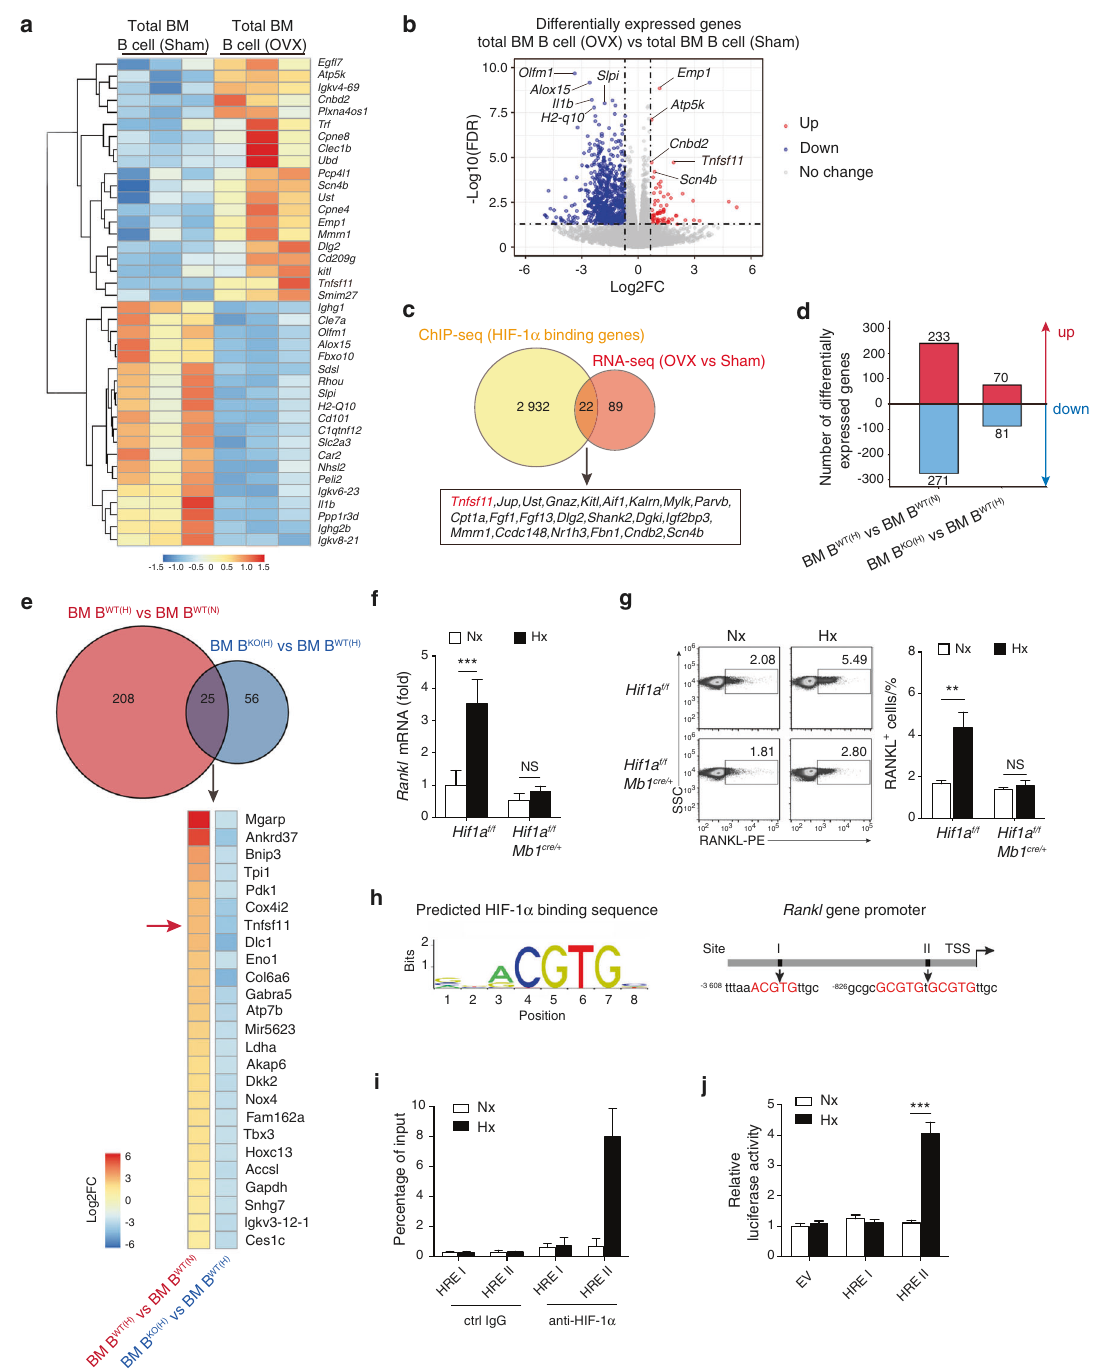
Fig. 2 HIF-1 α signaling activation in B cells enhances RANKL production. a Differentially expressed genes in total B cells from bone marrow of sham control (Sham) or ovariectomized (OVX) mice ( n = 3). b Volcano plot of RNA-seq analysis of total B cells from bone marrow of Sham and OVX mice showing upregulated and downregulated genes ( n = 3). c Experimental outline that led to the discovery of RANKL ( Tnfsf11 ) as a HIF-1 α target gene during ovariectomy-induced bone loss. d Number of differentially expressed genes in WT and Hif1a -de fi cient bone marrow B cells after normoxic or hypoxic culture for 12 h. WT B cells under hypoxia, B WT (H) ; WT B cells under normoxia, B WT (N) ; Hif1a -de fi cient B cells under hypoxia, B KO (H) ; Hif1a -de fi cient B cells under normoxia, B KO (N) . e Venn diagram depicting overlap of differentially expressed genes between hypoxic WT B cells versus normoxic WT B cells (red circle) and hypoxic Hif1a -de fi cient B cells versus hypoxic WT B cells (blue circle). Heatmap showing the commonly differentially expressed genes. Color scale indicates Log 2 fold change. f Rankl mRNA expression in Hif1a -de fi cient B cells or control B cells after normoxic (Nx) or hypoxic (Hx) culture for 12 h ( n = 6). g RANKL expression in B cells isolated from the bone marrow of Hif1a f/f or Hif1a f/f Mb1 cre/ + mice after normoxic (Nx) or hypoxic (Hx) culture for 24 h ( n = 6). h Transcription factor HIF-1 α binding sequence in the JASPAR database (left) and schematic analysis of hypoxia response elements (HREs) on the Rankl promoter (right). i ChIP assays showing the binding of HIF-1 α to the Rankl promoter in total bone marrow B cells after normoxic (Nx) or hypoxic (Hx) culture for 12 h ( n = 3). j Luciferase reporter assay in CH12F3 cells transfected with empty vector (EV) or HRE constructs (I and II) after normoxic (Nx) or hypoxic (Hx) culture for 24 h ( n = 3). ** P < 0.01, *** P <